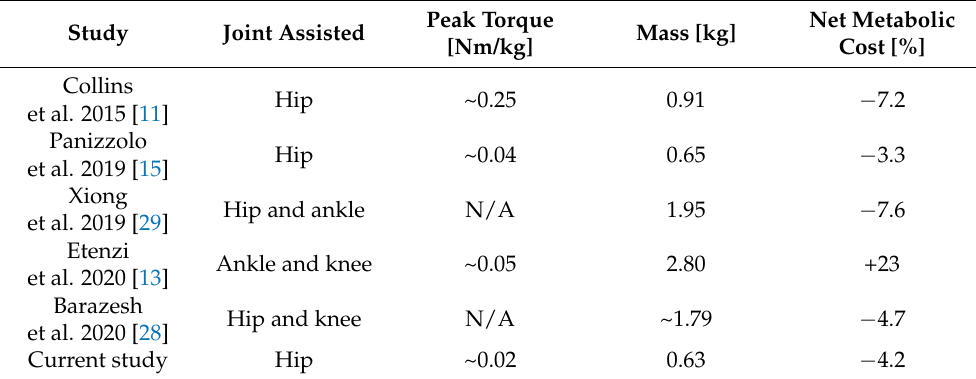
Table 2. State of the art of passive assistive devices. The table includes information on the joint assisted, peak torque and mass of